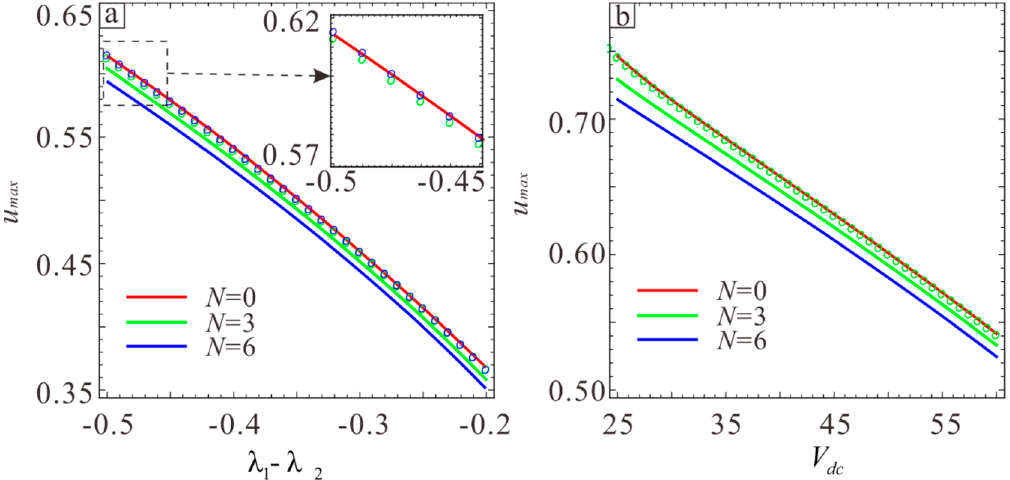
Figure 16. The relationship between the transition points and physical parameters of the system under different residual stresses. ( a ) The relationship between the transition points and λ 1 − λ 2 . ( b ) The relationship between the transition points and DC voltage. The straight line shows the result obtained with Equation (41). Circles show the exact position of the transition point obtained by the Equation (40).